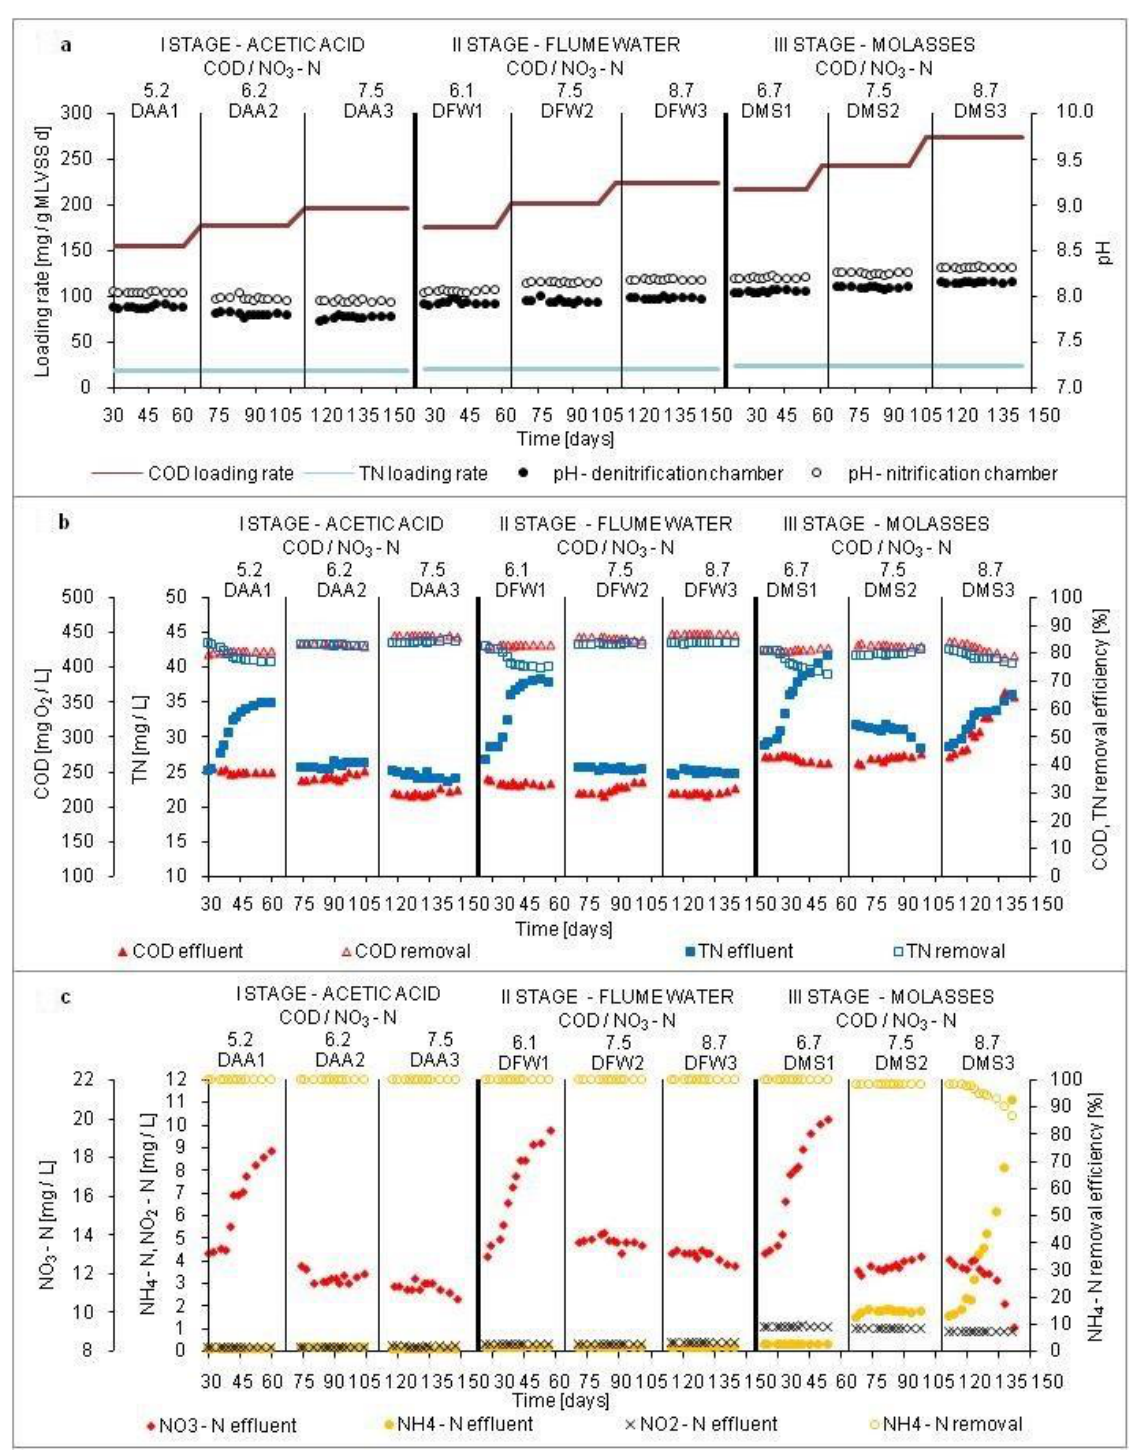
Figure 2. Operating parameters of reactors ( a ); COD and TN concentration in effluents and COD and TN removal efficiency ( b ); NH 4 – N, NO 3 – N, and NO 2 – N concentration in effluents and NH 4 – N removal efficiency ( c ).